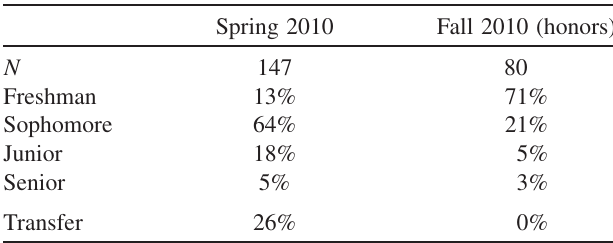
TABLE I. Demographics of students enrolled in Org Bio in spring and fall